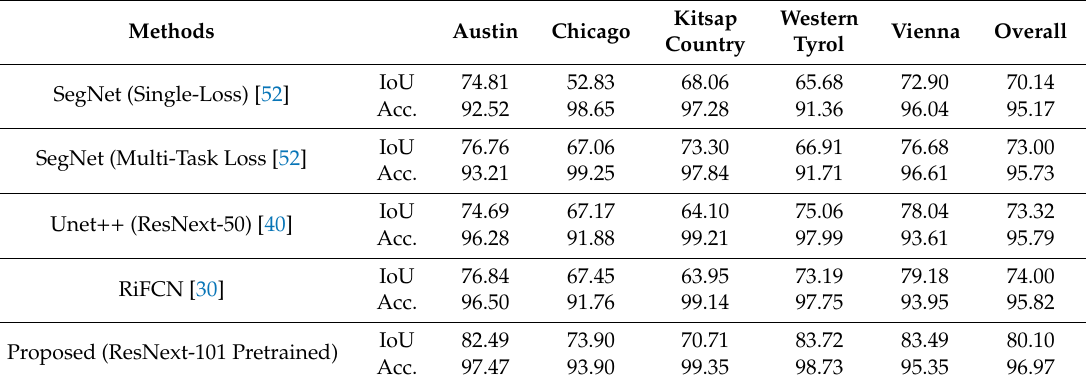
Table 6. Numerical Results among Cities.